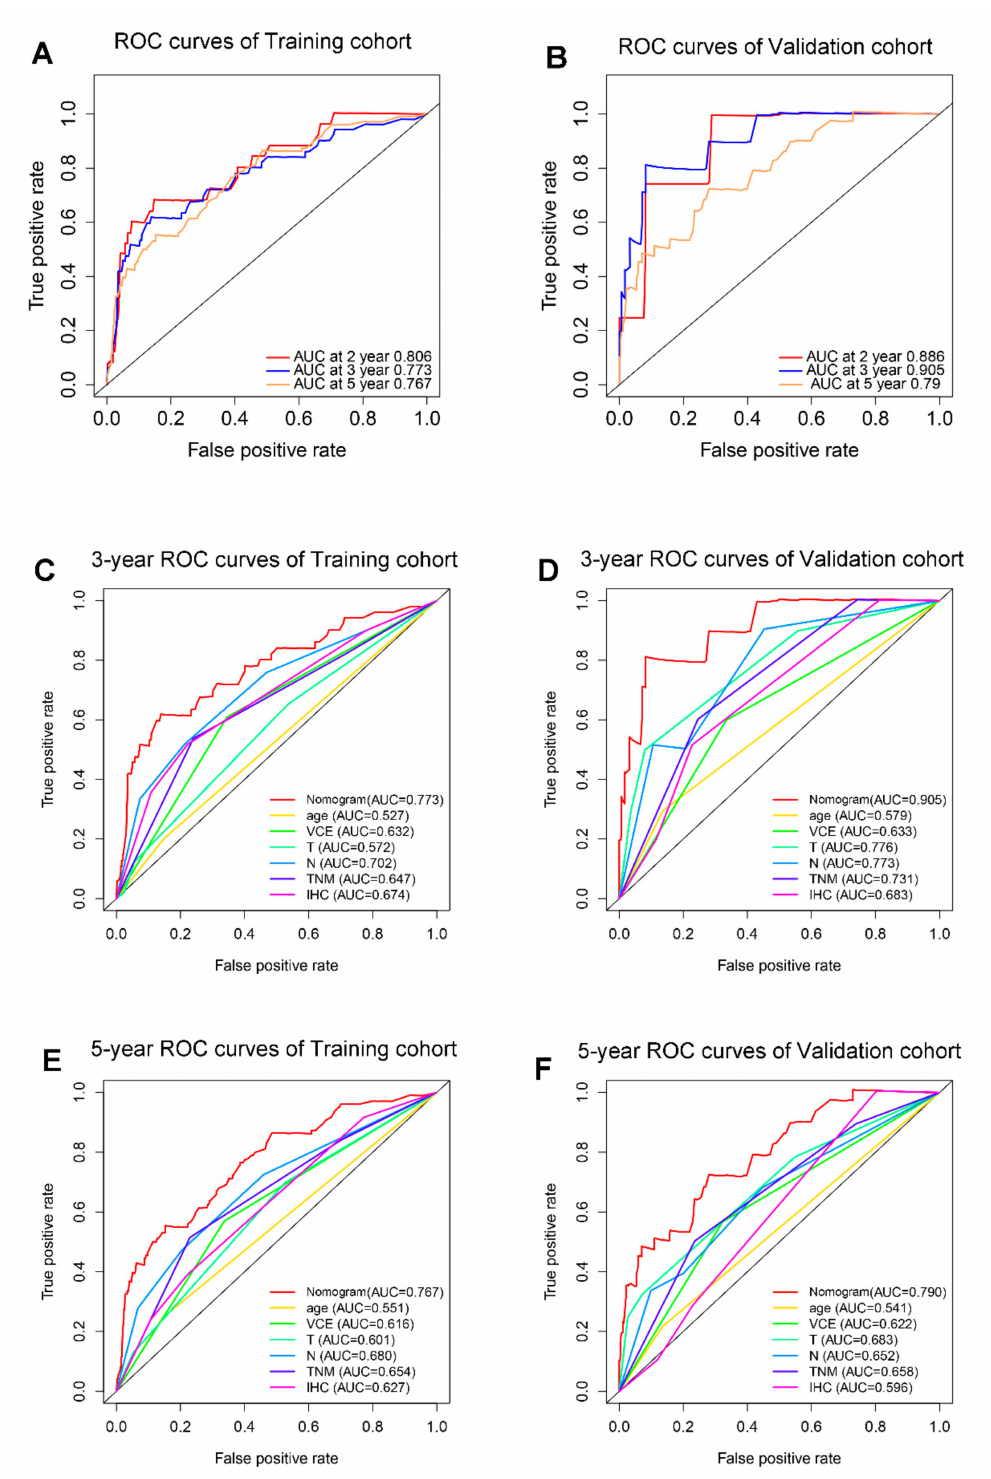
Figure 4. The predictive performance of the nomogram is better than that of traditional prognostic factors. ( A ). AUC of time-dependent ROC curves verified the prognostic accuracy of the nomogram in the training cohort. ( B ). AUC of time-dependent ROC curves verified the prognostic accuracy of the nomogram in the external validation cohort. ( C , D ). AUC of ROC curves compared the prognostic accuracy for 3-year survival of the nomogram and traditional prognostic factors in the training cohort and external validation cohort. ( E , F ). AUC of ROC curves compared the prognostic accuracy for 5-year survival of the nomogram and traditional prognostic factors in the training cohort and external validation cohort. Abbreviation: vascular cancer emboli